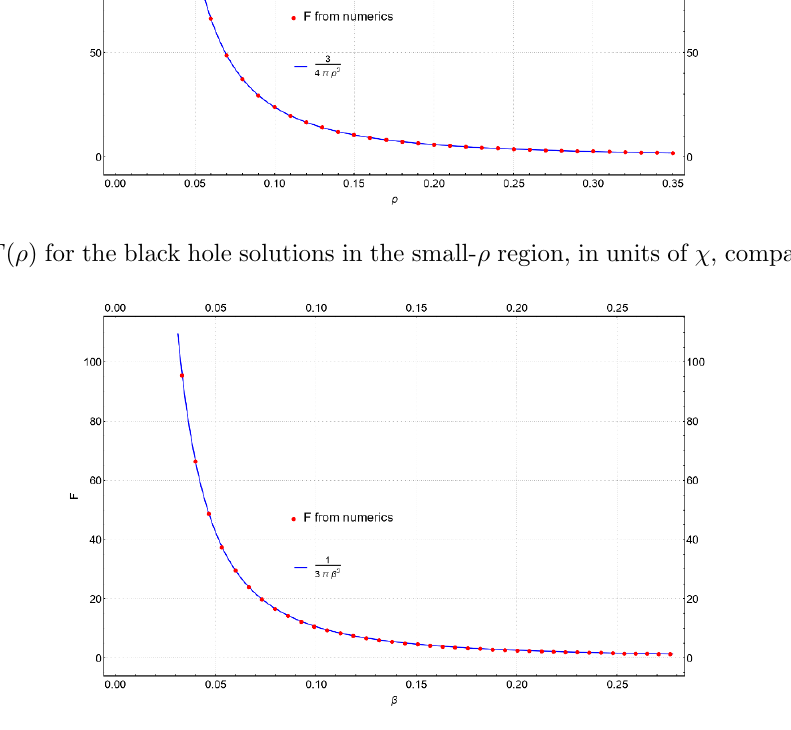
Figure 11 . F ( (cid:12) ) for the black hole solutions in the small- (cid:12) region, in units of (cid:31) , compared to (cid:12) 2 H . Here (cid:12) is measured in units of (cid:12) H 3 (cid:25)(cid:12) 2